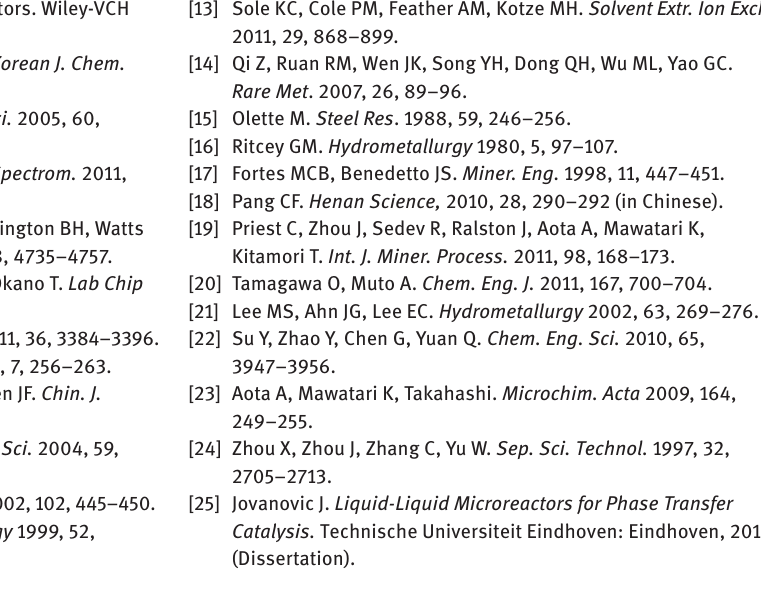
organic phase calculated by the data shown in Table 2. The mass transfer speed can be as high as 0.34 g·m -2 ·s -1 . The surface-to-volume ratio was about 6.8 × 10 3 m 2 /m 3 for this channel, which is much higher than that of the traditional mixing settler process. The surface-to-volume ratio of conventional scale laboratory or industrial reac- tors are usually in the range of 100~1000 m 2 /m 3 [25].